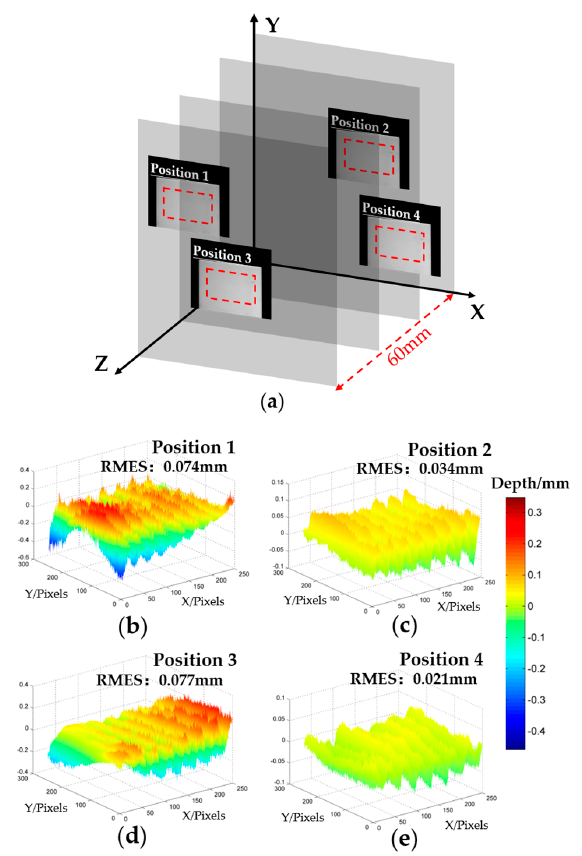
Figure 6. Accuracy analysis of our proposed method. ( a ) Four positions of the ceramic standard flat in the measured field; ( b )–( e ) Error distribution of standard flats of the four positions.